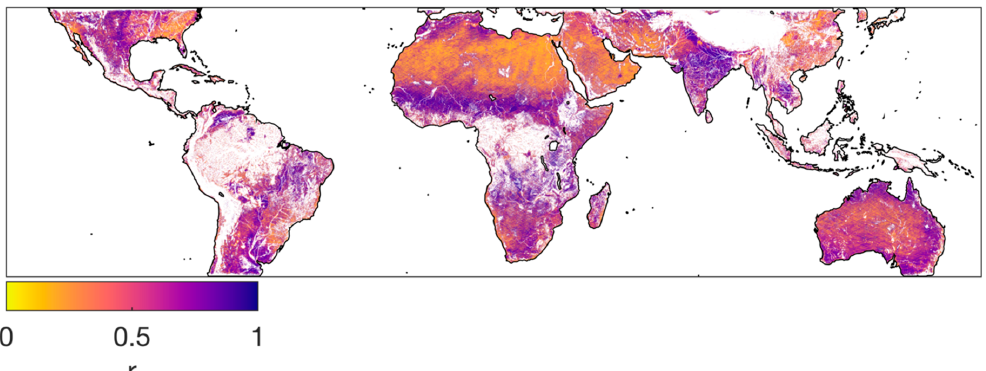
Figure 6. The correlation coefficient between SMAP soil moisture and CYGNSS effective reflectivity observations. Open water points have been removed. In general, there is a higher correlation coefficient when there is high soil moisture variability throughout the year. Areas in white either contained open water and were thus not used in the analysis, or they are regions too vegetated or mountainous to produce reflections over the SNR threshold of 2 dB.